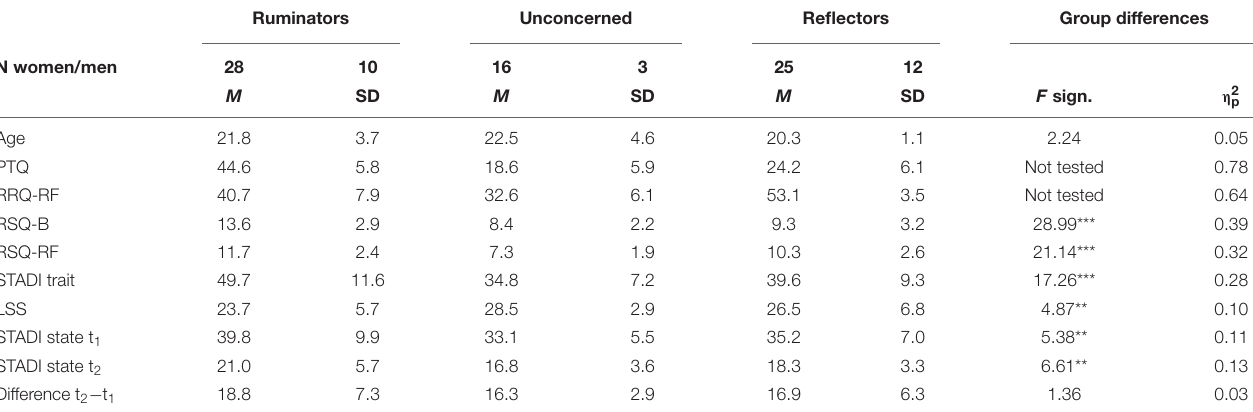
TABLE 1 | Characteristics of ruminators, unconcerned, and reflectors. Ruminators Unconcerned Reflectors Group